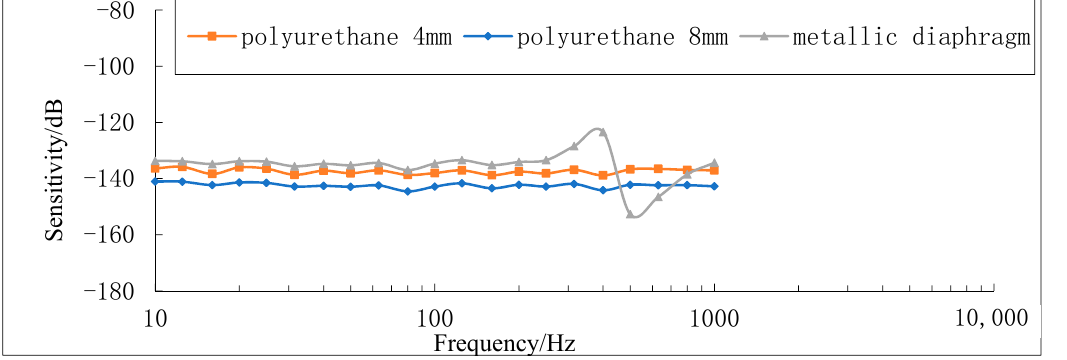
Figure 8. Frequency response ratio curve of FLH.